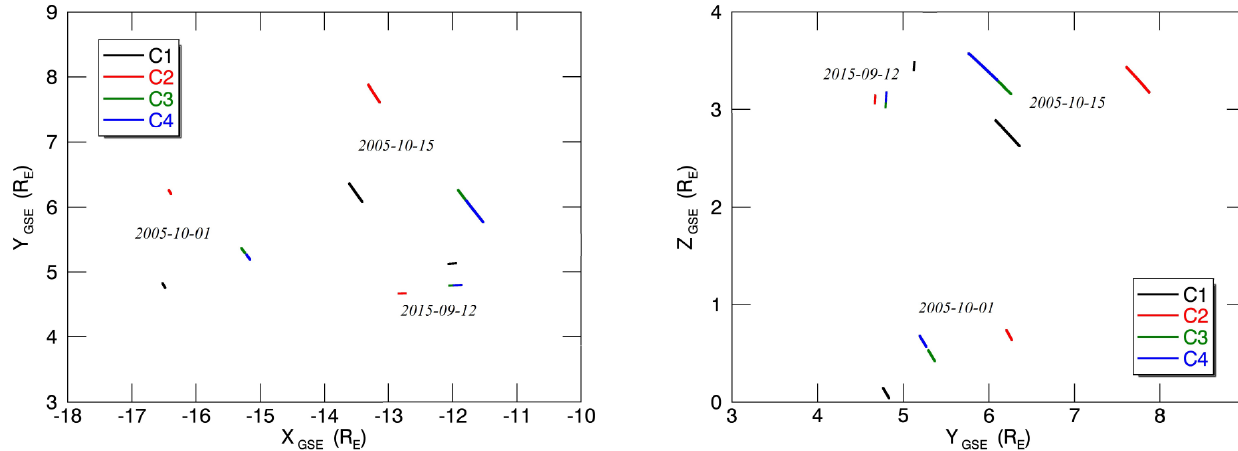
Figure 2. The locations of the satellites. Table 2. Estimated values of plasma characteristics in the dipolarization region. SC Average proton- Number density Electron plasma Ion plasma Electron inertial Ion inertial cyclotron frequency of electrons, frequency, frequency, length, λ e , length, (cid:104) f C (cid:105) p